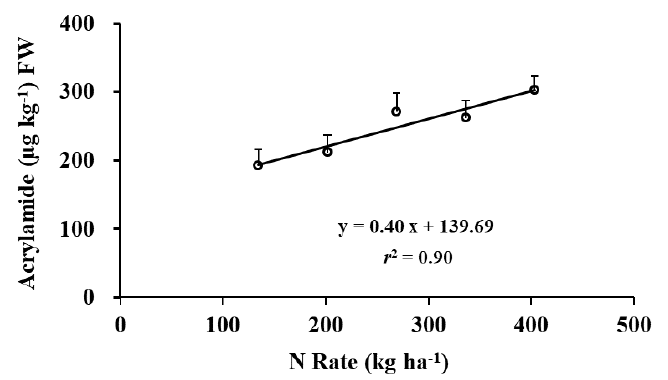
Figure 6. N rate effect on acrylamide concentration after 16 weeks of storage. Figure 6. N rate e ff ect on acrylamide concentration after 16 weeks of